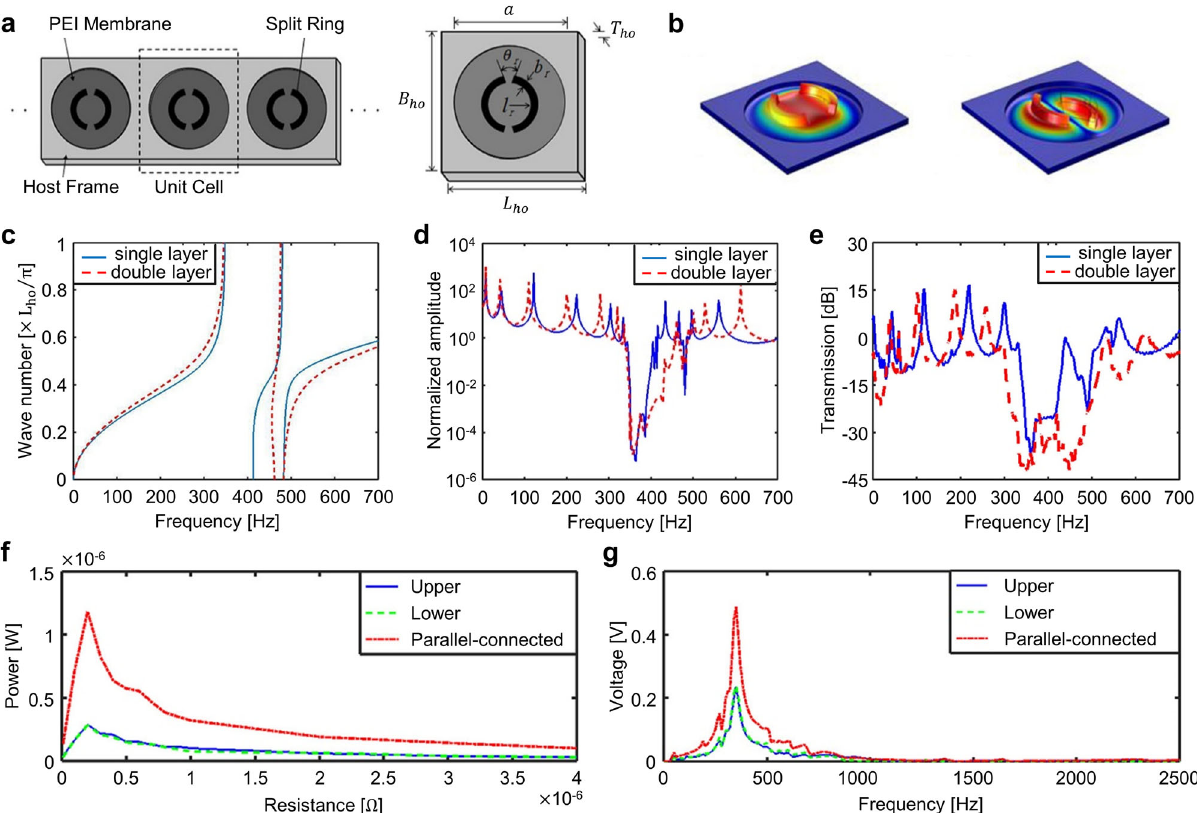
Fig. 3 Metamaterial (MM) beam with membrane-split-ring resonators for energy harvesting. a Con fi guration of a membrane-split-ring resonator embedded in a MM beam and a single unit cell. The membrane is a polyetherimide (PEI) fi lm. b Mode shapes at the cutoff frequency of the fi rst and second bandgaps. c Band structures of the MM beam with single- and double-layer resonators; both have two bandgaps in which the wave cannot propagate through the system. d , e Simulated and experimental frequency responses of the MM beam. f , g Output power and voltage of the MM beam with double- layer resonators 63 . Reprinted with permission from ref. 63